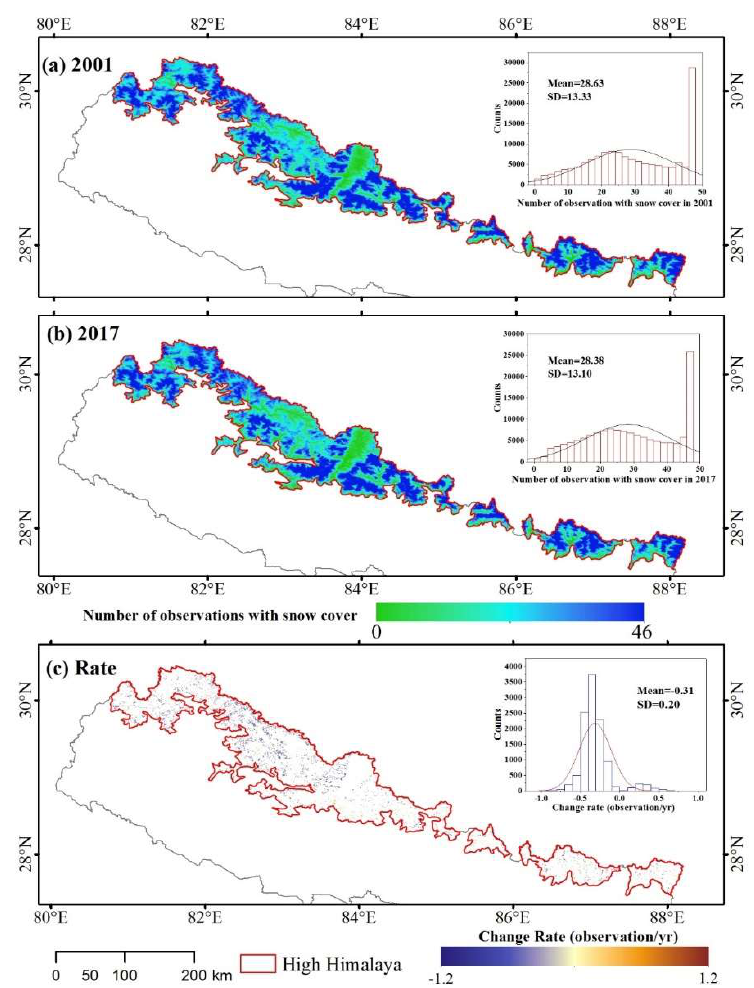
Figure 11. Number of observations with the snow cover in ( a ) 2001 and ( b ) 2017, based on the MODIS 8-day snow cover product; and ( c ) the trend test during the period from 2001 and 2017.